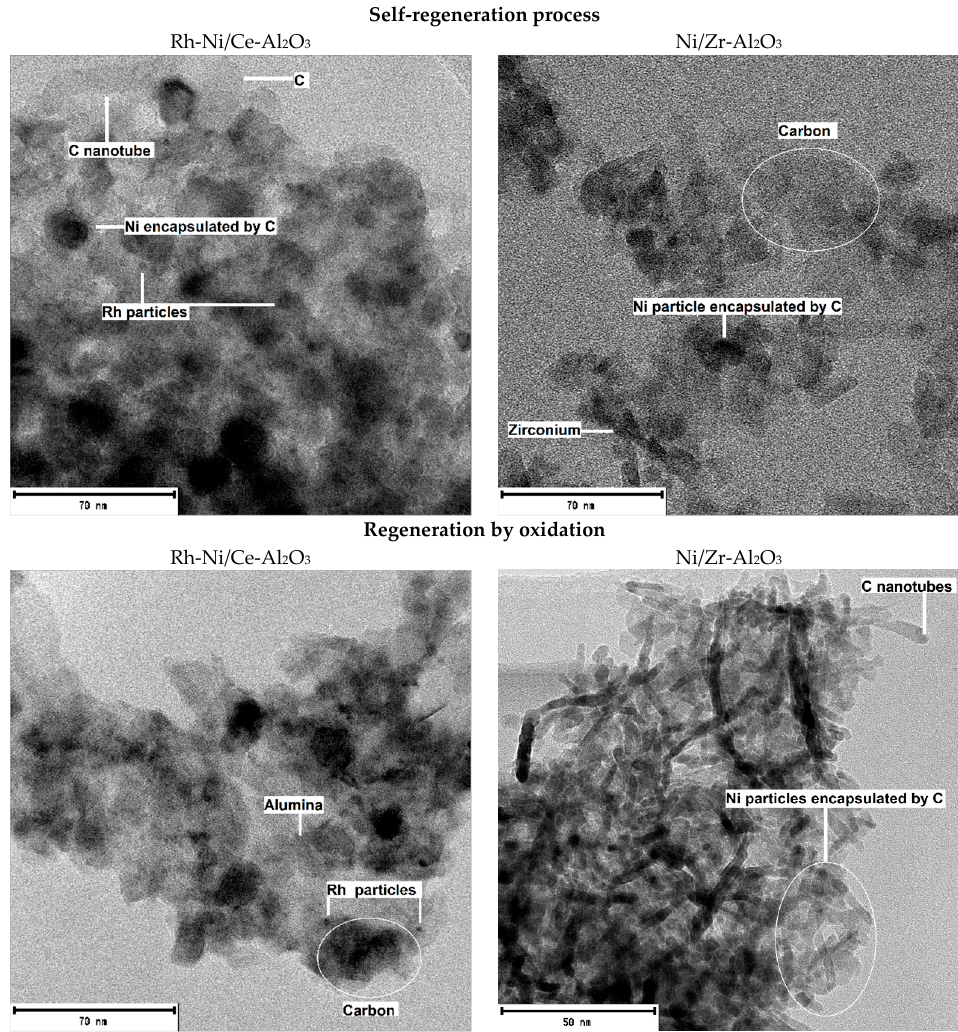
Figure 5. TEM micrographs for the catalyst that showed best ( left , Rh-Ni/Ce-Al 2 O 3 ) and worst ( right , Ni/Zr-Al 2 O 3 ) activity results, tested after self-regeneration ( top ) and regeneration by oxidation ( bottom ). Reaction conditions: 210.0 mL/min CH 4 , 140.0 mL/min CO 2 , 197.7 mL/min N 2 , 52.5 mL/min O 2 , 0.169 mL/min H 2 O at 800 ◦ C and atmospheric pressure. Weight Hourly Space Velocity (WHSV) of 161.5 g gas · g cat − 1 · h − 1 (0.340 g of each